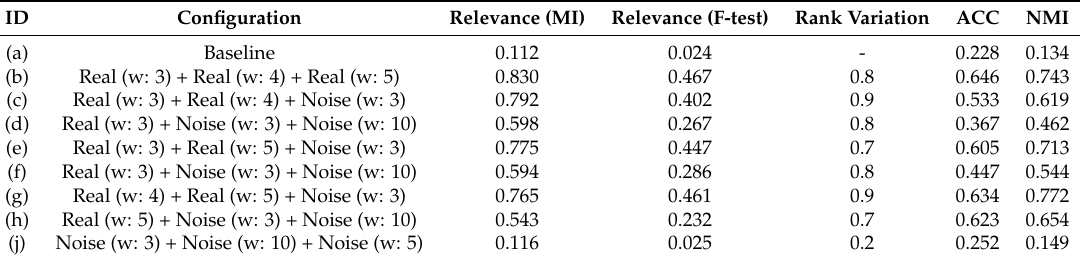
Table 5. The CIFAR-10 dataset results experimenting with three sources of evidence: we use real corresponding evidence introduced in Table 2. We experiment with more combinations of real and white noise evidence.